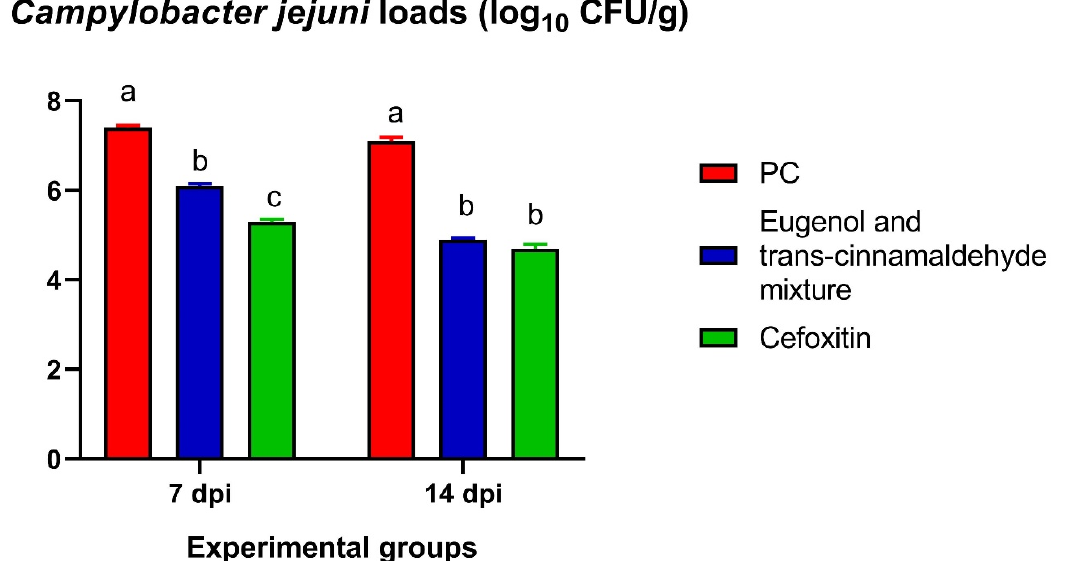
Figure 7. Quantification of the fecal Campylobacter jejuni loads (log 10 CFU) in response to supple- menting the mixture of eugenol and trans-cinnamaldehyde and treatment with cefoxitin antibiotic at 7 days (7 dpi) and 14 days post-infection (14 dpi) with XDR C. jejuni , as were determined via the qPCR assay. The results are expressed as the means ± standard error of the mean (SEM, error bars). PC (positive control): chicks fed a basal diet and challenged with XDR C. jejuni ; eugenol and trans- cinnamaldehyde mixture: chicks fed a basal diet supplemented with a mixture of eugenol and trans- cinnamaldehyde; and cefoxitin: chicks fed a basal diet supplemented with a cefoxitin antibiotic. All groups, except the NC group, were challenged with XDR C. jejuni at 23 days of age. a–c Means of the columns with different letters indicate a statistically significant difference ( p < 0.05).